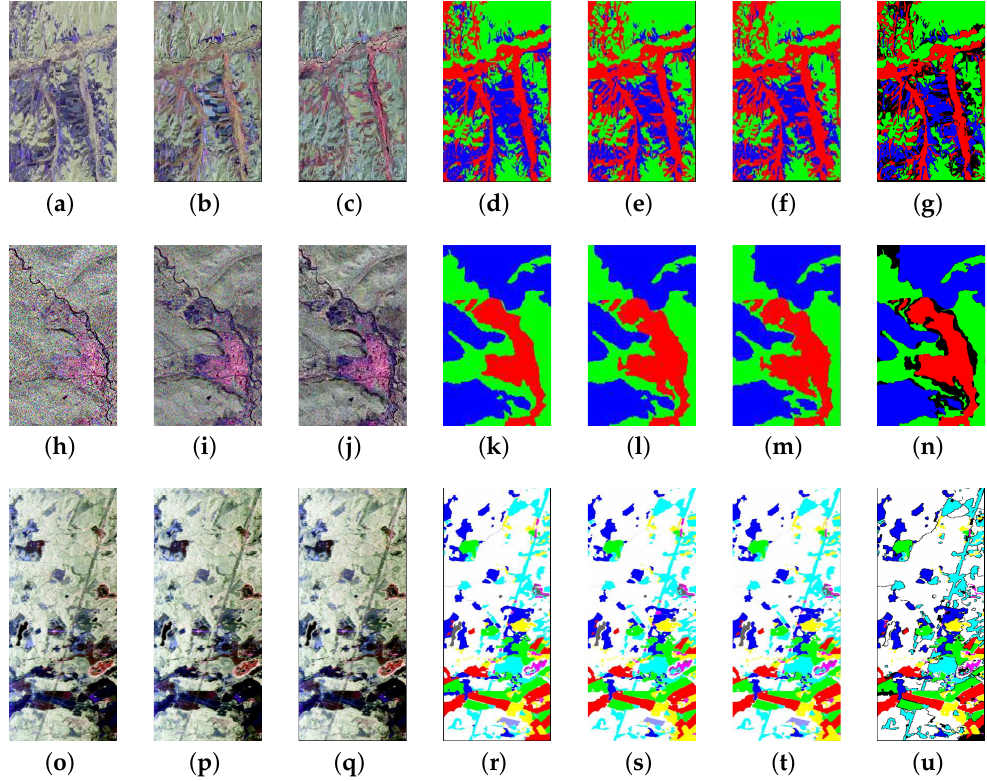
Figure 4. ( a – c ) present images of data set 1; ( d – f ) are their corresponding label truths and ( g ) is the shared label truth. ( h – j ) present images of data set 2; ( k – m ) are their corresponding label truths and ( n ) is the shared label truth. ( o – q ) present images of data set 3; ( r – t ) are their corresponding label truths and ( u ) is the shared label